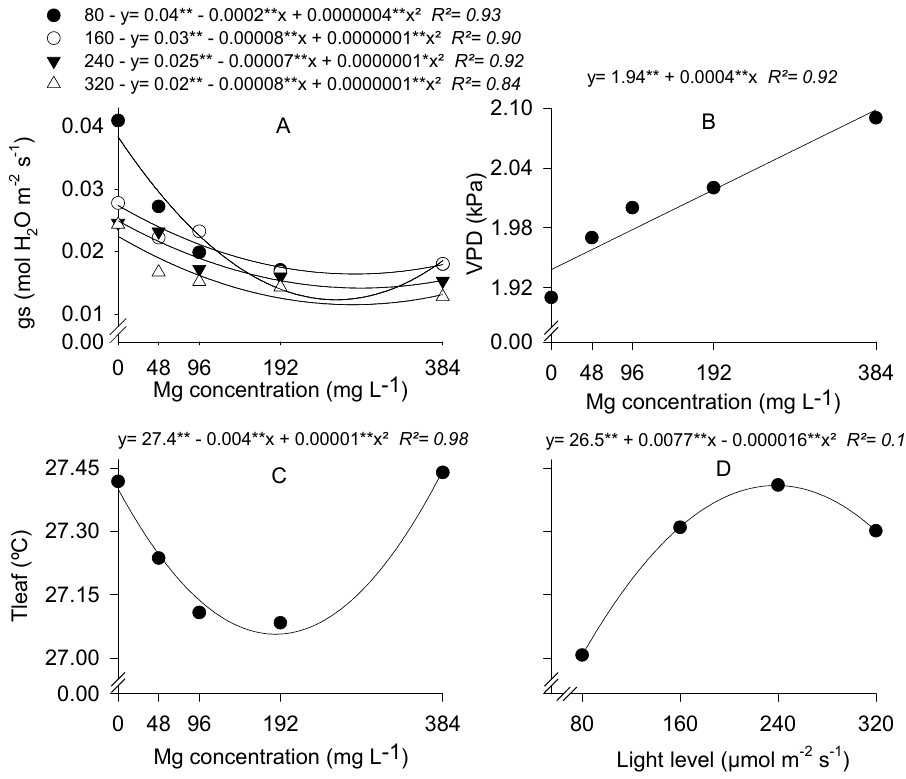
Figure 1. ( A ) Stomatal conductance (Gs; mol H 2 O m − 2 · s − 1 ), ( B ) vapor pressure deficit (VPD; kPa), and ( C , D ) leaf temperature (Tleaf; °C) in coffee seedlings grown with different Mg concentrations and under different light levels. (*) Significant according to the t test at p < 0.05. (**) Significant according to the t test at p < 0.01.